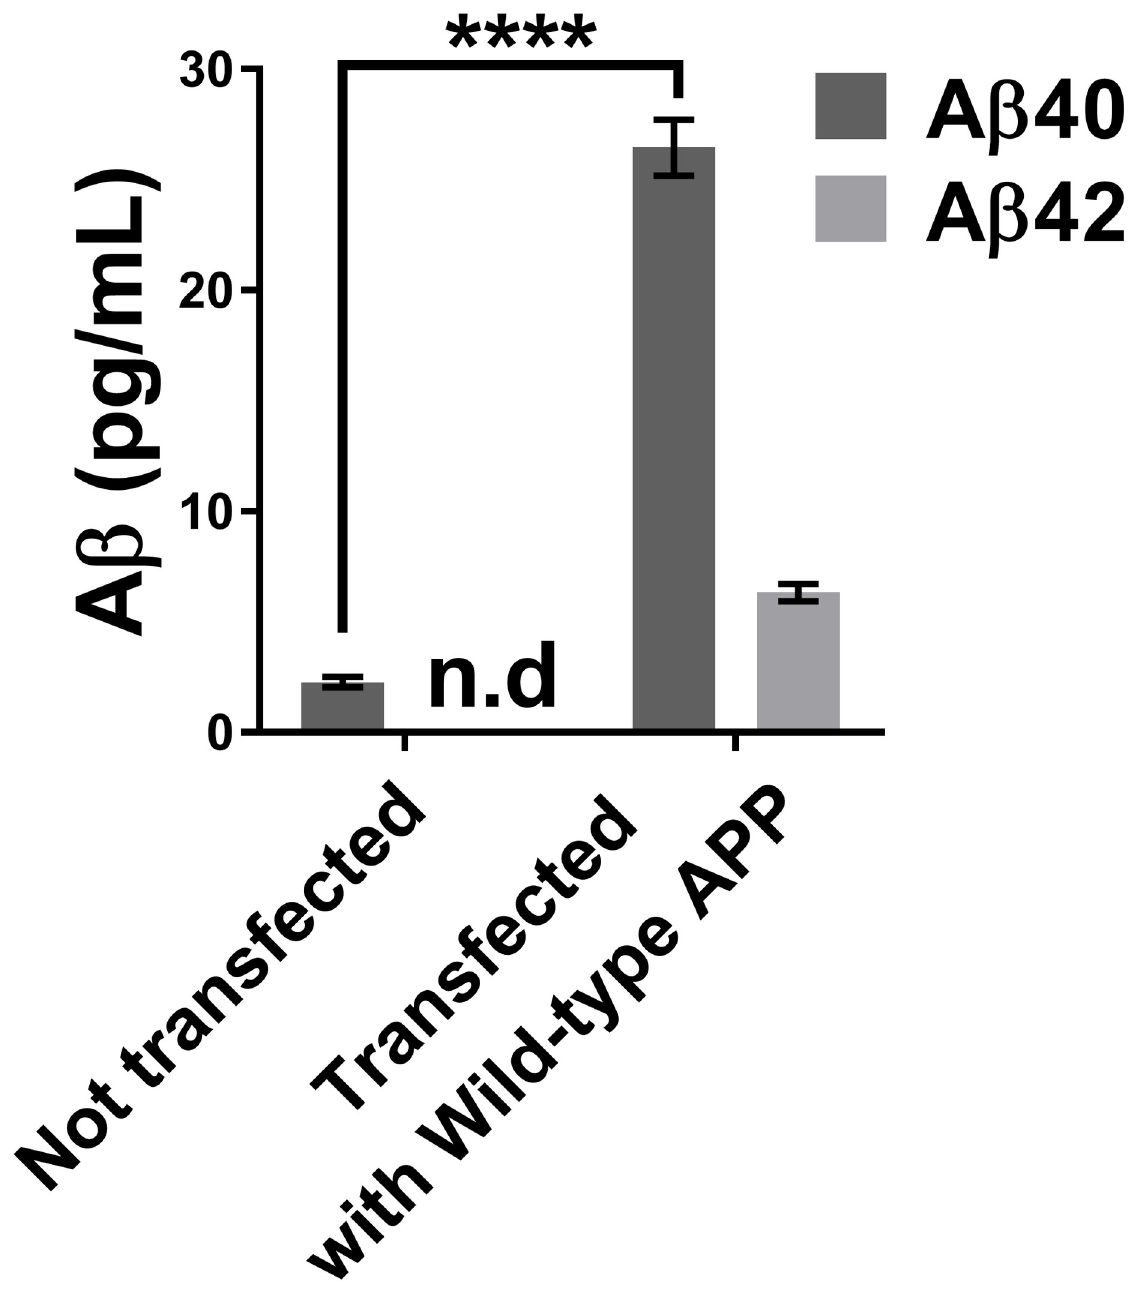
Fig 2. Concentrations of A β 40 and A β 42 in the neuroblastoma supernatant using the MSD Elisa test. The neuroblastoma transfection with a wild APP plasmid increased the concentrations of A β 40 and A β 42 peptides in the cell culture medium. Statistic test: Two-way ANOVA Sidak’s multiple comparisons test. P value style ���� p < 0.0001. n.d: not detectable.